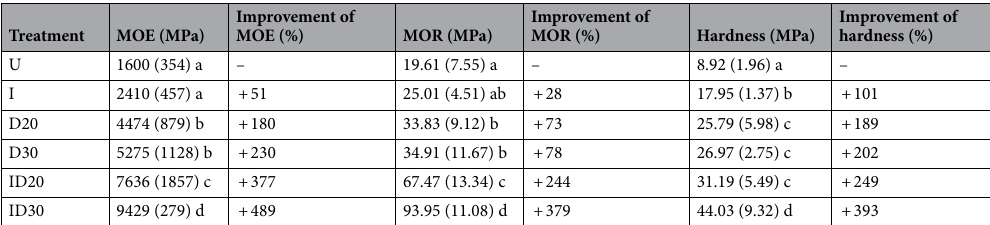
Table 6. Mechanical properties of modified inner part of oil palm trunk. Notes: Values in parentheses are standard deviations. U = Untreated; I = Impregnation; D20 and D30 = densification with compression ratio (CR) 20% and 30%, respectively; ID20 and ID30 = compregnation with CR 20% and 30%, respectively. Different letters in the same column indicate significant differences at 5% level of significance based on Duncan’s multiple range